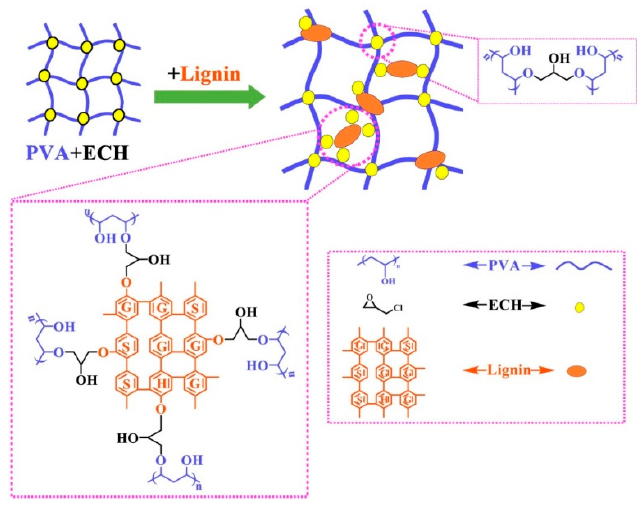
Figure 7. Schematic representation of the preparation of PVA/lignin hydrogels crosslinked with epychlorhydrin. Reproduced with permission from Wu et al. [49]. Copyright © (2019) Elsevier.